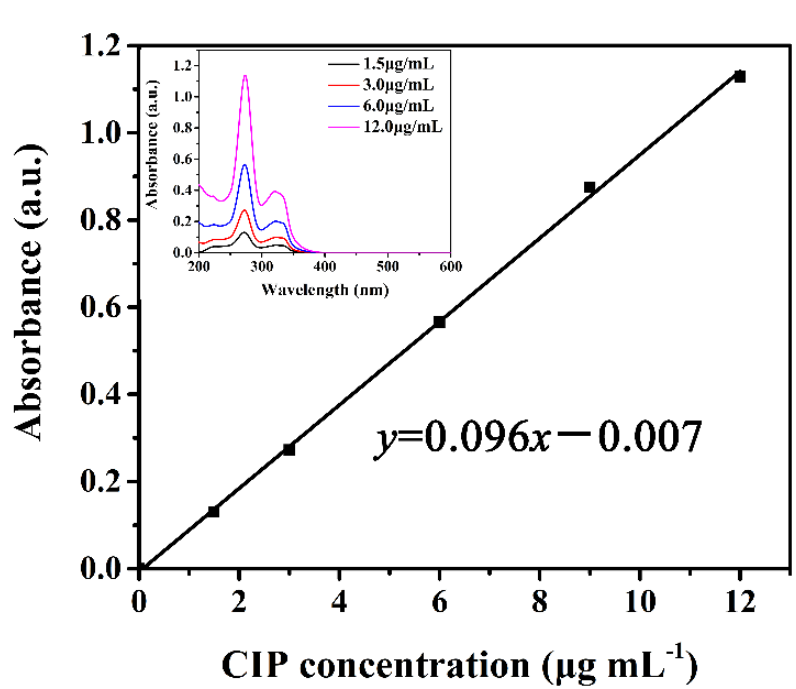
Figure 5. The UV absorbance of CIP as a function of varying CIP concentration.